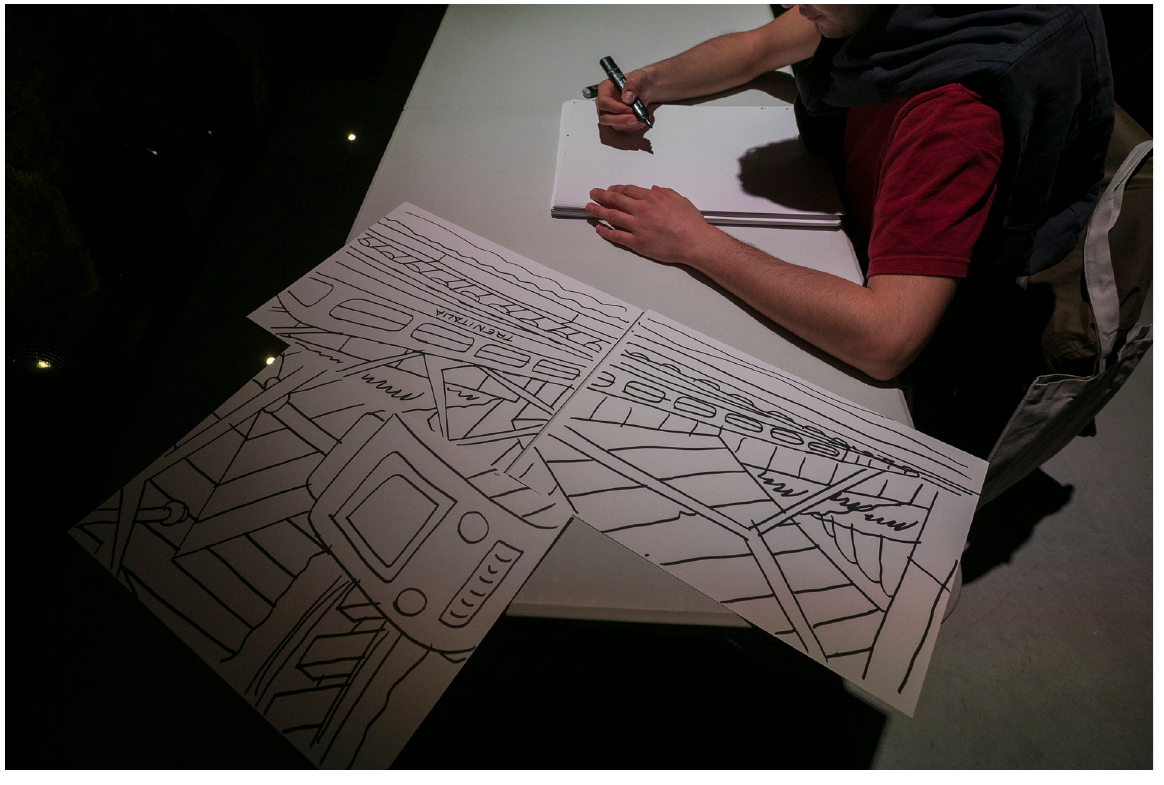
Lorenzo Filardi, Trenitalia,